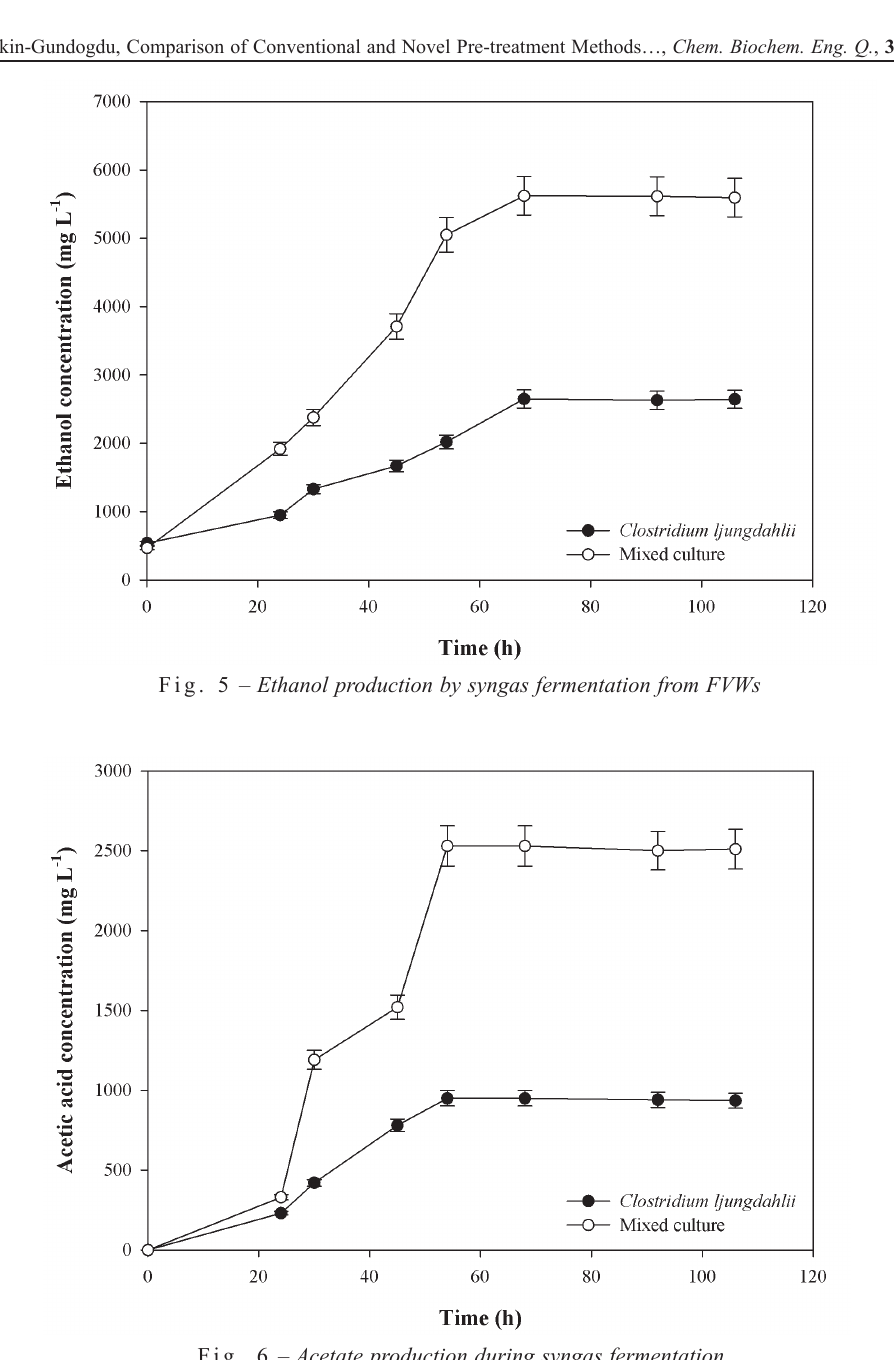
Fig. 6 – Acetate production during syngas